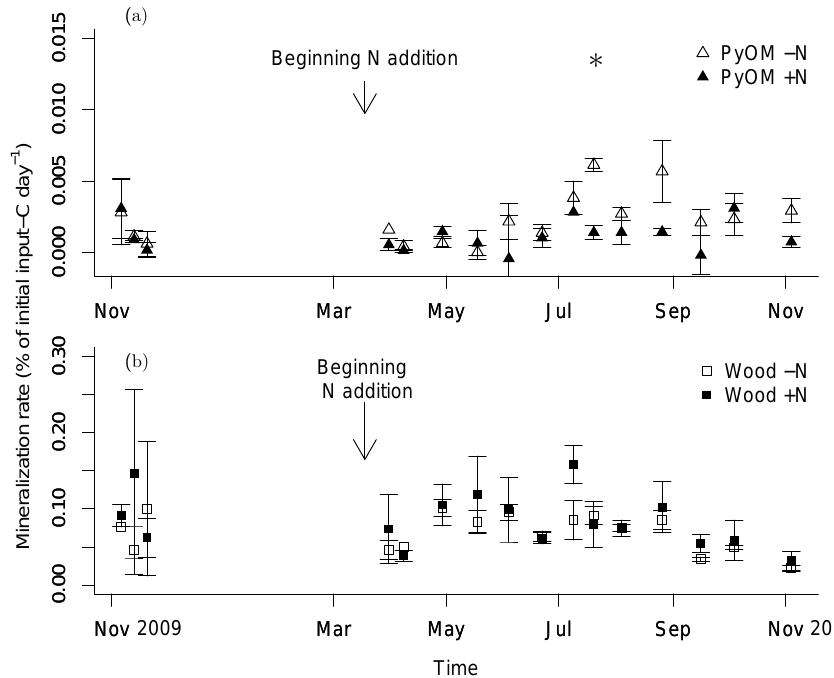
Figure 3. Mineralization rate (in µmol CO 2 m − 2 s − 1 ) of wood (a) and PyOM (b) . Empty symbols represent the treatment under ambient N and full symbols under increased N. Asterisks ( ∗ ) indicate the dates when the addition of N significantly affected substrate mineralization (paired t test, P < 0 . 05). Error bars represent the standard error of the mean ( n = 3).